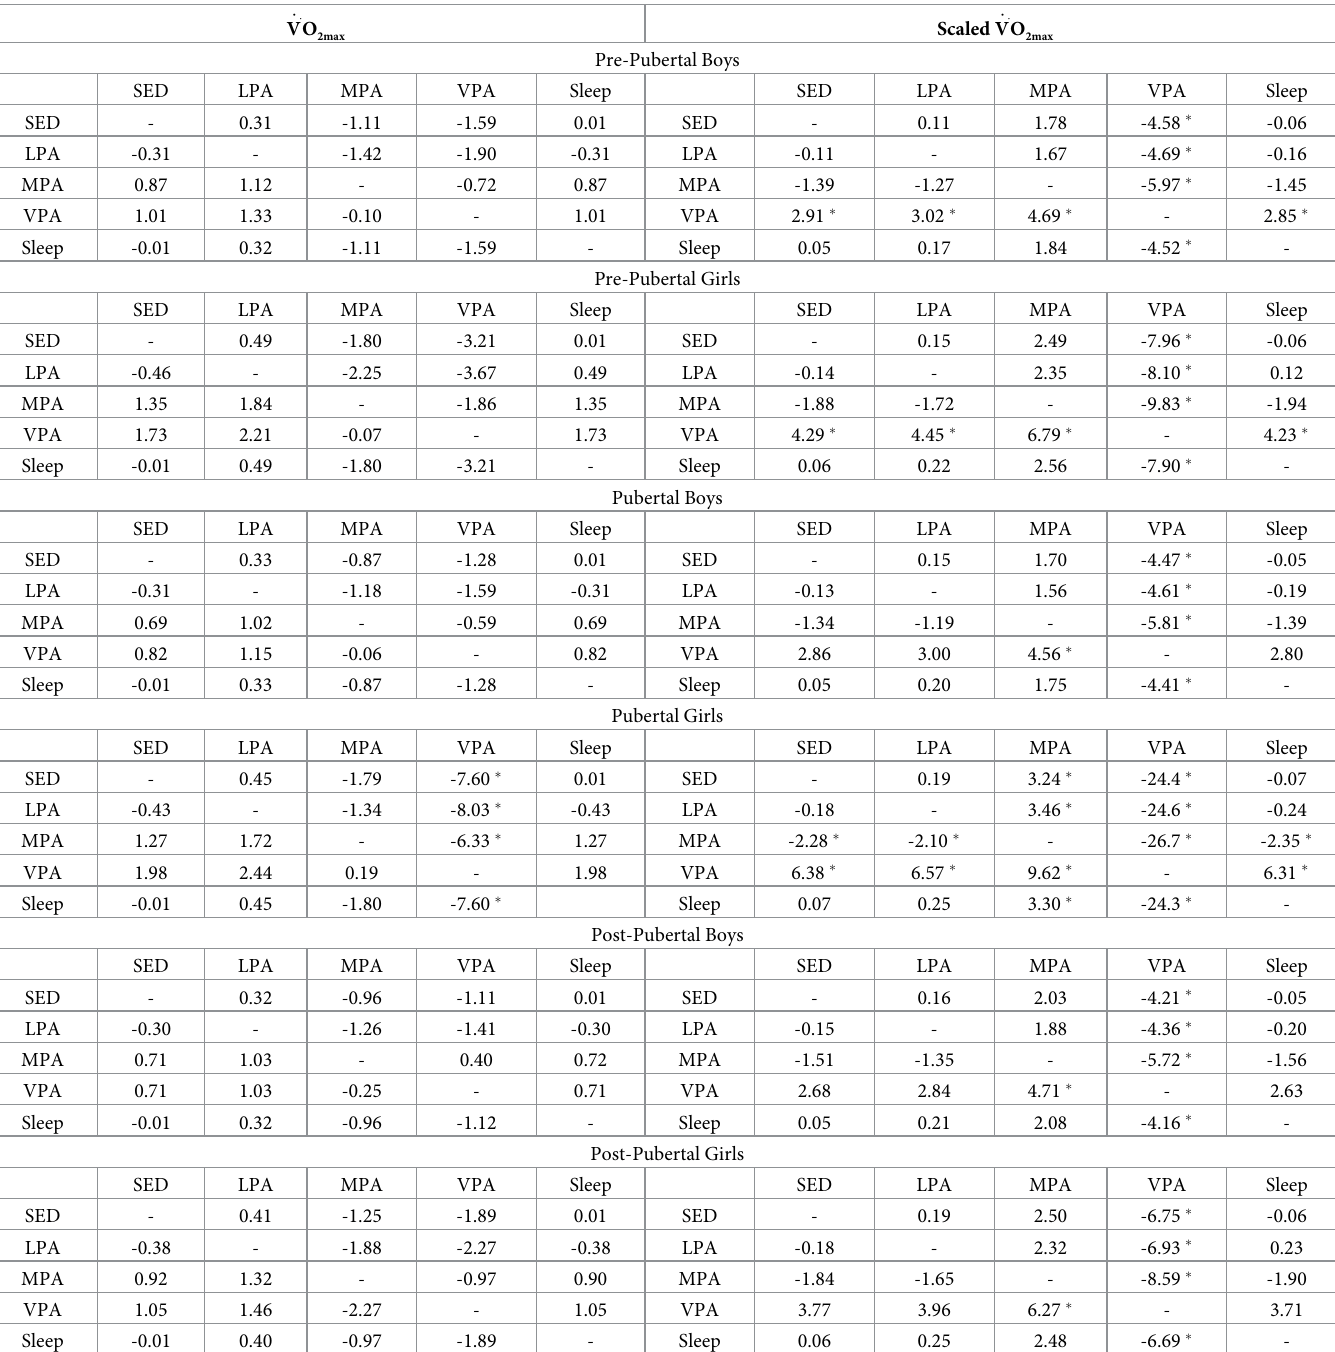
(l � min -1 ) and scaled